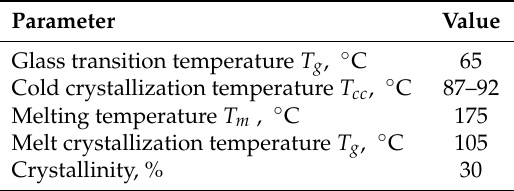
Table 1. Physicochemical characteristics of polymer composites after hot pressing